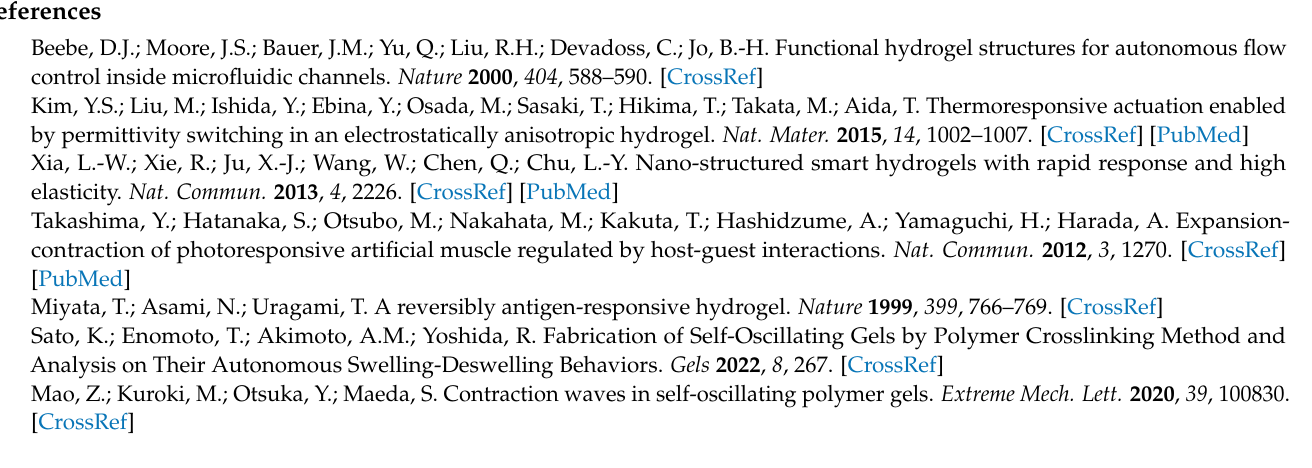
curves; Figure S2: Effects of MBAAm on stress-strain curves; Figure S3: Fracture toughness of gels as measured by the pure shear method introduced by Rivlin and Thomas; Figure S4: FT-IR spectra of alginate, PNIPAAm, and PNIPAAm-alginate